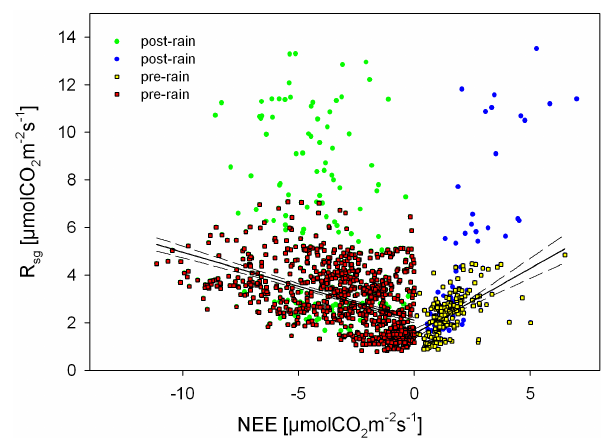
Fig. 12. Gradient flux from the upper soil layer ( R sg ) in the func- tion of pre- and post-rain daytime uptake and nighttime Reco val- ues, respectively (data from periods without rain in the preceeding 36h were considered as pre-rain). Eddy data have been u ∗ -filtered ( u ∗ > 0.1ms − 1 ) . Regressions lines (and confidence intervals) are shown for the pre-rain values. Regression statistics for pre-rain data are shown in Table 5.